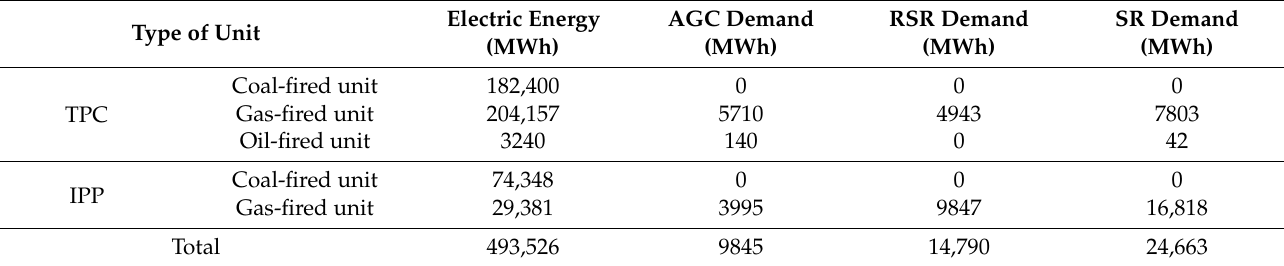
Table 1. Assigned quantities of various units on a typical non-summer day.